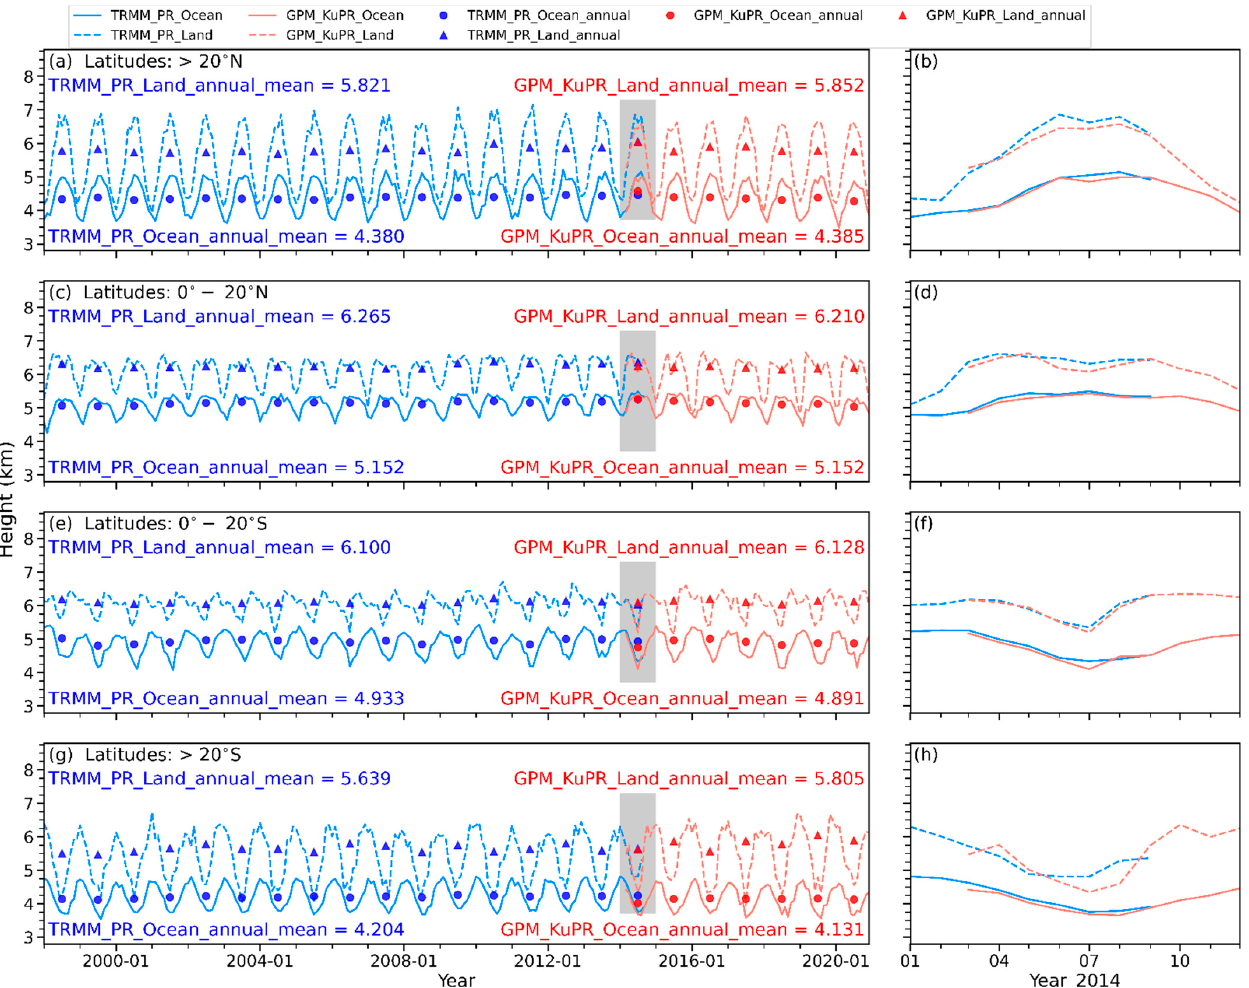
Figure 10. Time series (1998–2020) of monthly averaged Topht20 from the TRMM_PR (blue lines) and GPM_KuPR (red lines) within the latitudinal belt ( a , b ) greater than 20°N, ( c , d ) between 0°–20°N, ( e , f ) between 0°–20°S, and ( g , h ) greater than 20°S over land (dashed lines) and ocean (solid lines). Panels in the right column highlight the details in 2014. The annual mean Topht20s are denoted by triangles and dots over land and ocean, respectively. The mean values of Topht20s over land (ocean) from the TRMM_PR (1998–2014) and GPM_KuPR (2014–2020) are marked by text.